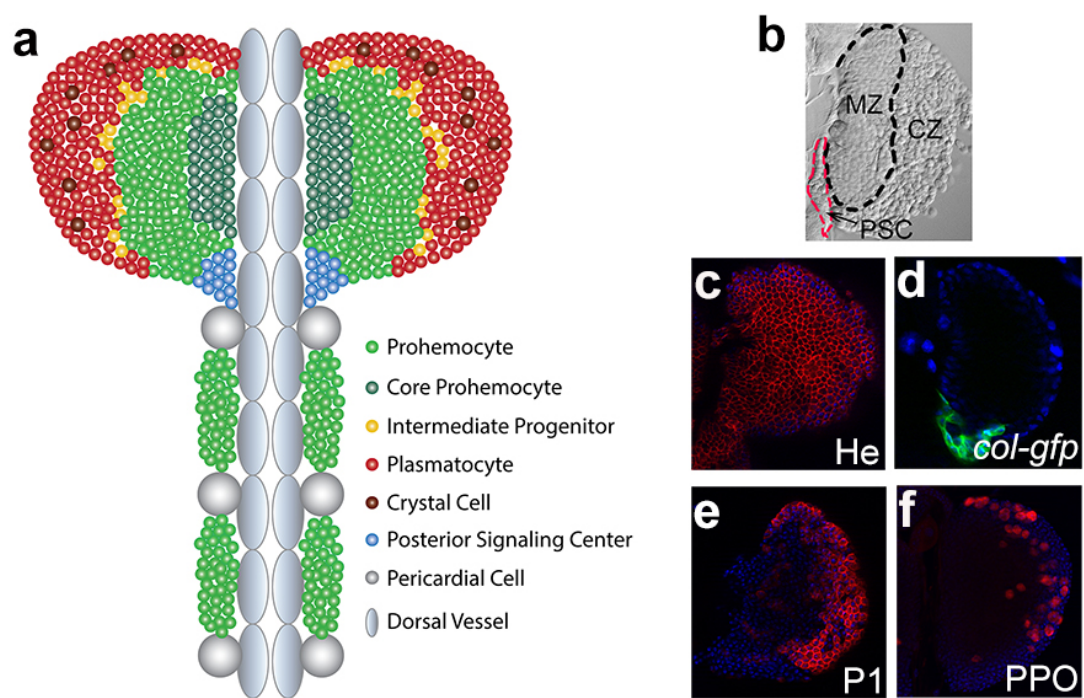
Figure 1. The lymph gland at the third instar larval stage. ( a ) A schematic diagram of the third-instar lymph gland. ( b ) A DIC image shows the morphological features of a primary lobe of the third-instar lymph gland. The black and red dashed lines outline the medullary zone (MZ) and posterior signaling center (PSC), respectively. The remaining area of the lobe is the cortical zone (CZ). ( c – f ) The immunofluorescence revealed by antibodies against Hemese (He), P1 antigen, or PPO, indicates pan hemocytes, plasmatocytes, and crystal cells, respectively, in red. The col-gfp transgene marks PSC in green. DAPI staining is blue.